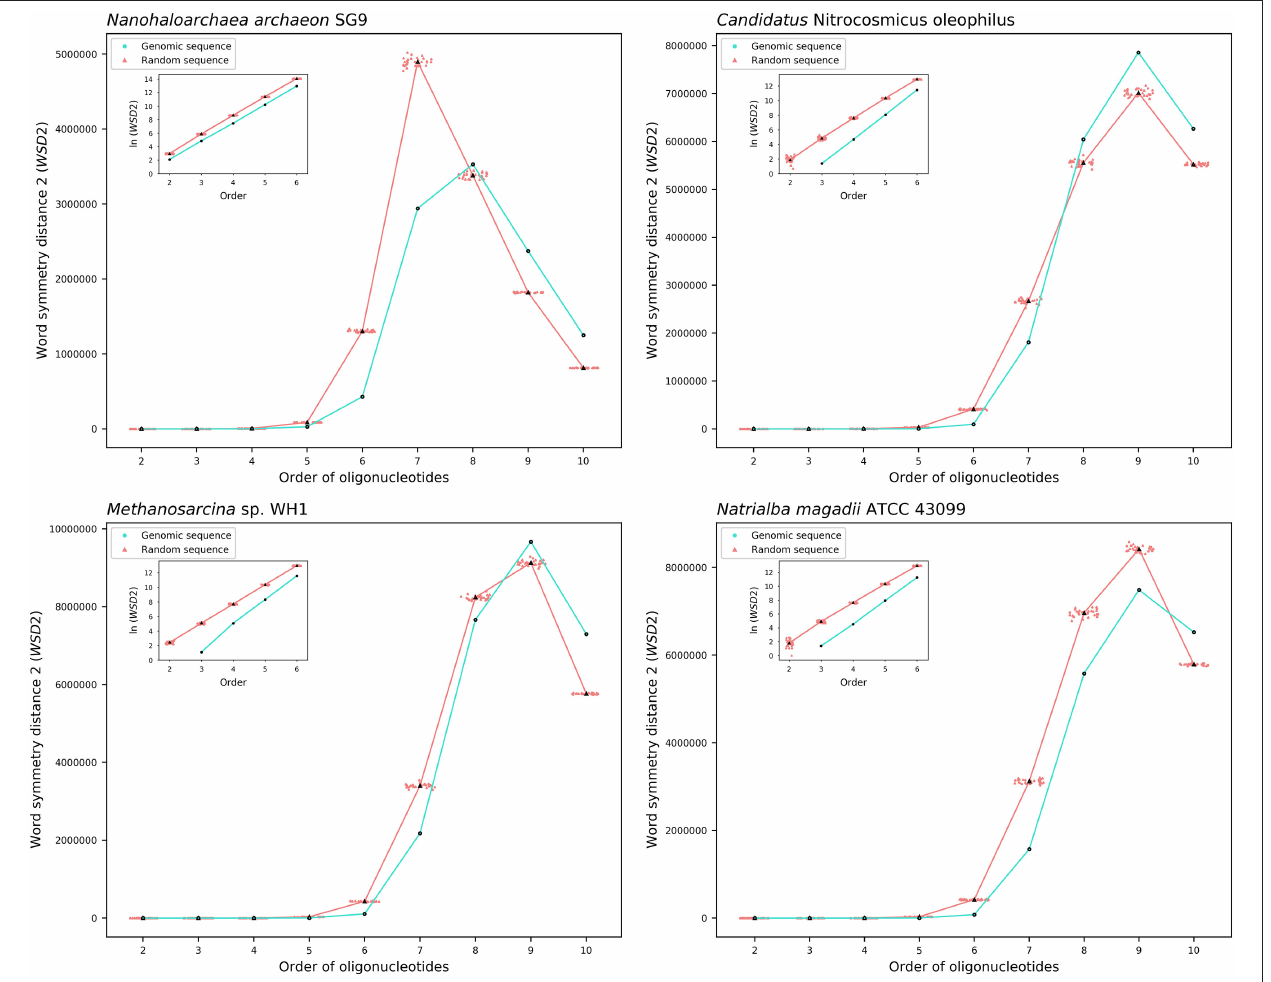
FIGURE 4 | Word symmetry distances ( WSD 2) for four representative archaeal genomes ( Nanohaloarchaea archaeon SG9, Candidatus Nitrocosmicus oleophilus, Methanosarcina sp. WH1, Natrialba magadii ATCC 43099) and their corresponding random sequences. WSD 2 value for each genome and the mean value for its corresponding random sequences, respectively, are marked for each order. Data dots for the random sequences are horizontally dispersed within the range of an order for better visualization. The values of WSD 2 are presented in natural logarithm in insets (the logarithmic value for genomic sequences may not be available at order 2 where WSD 2 is